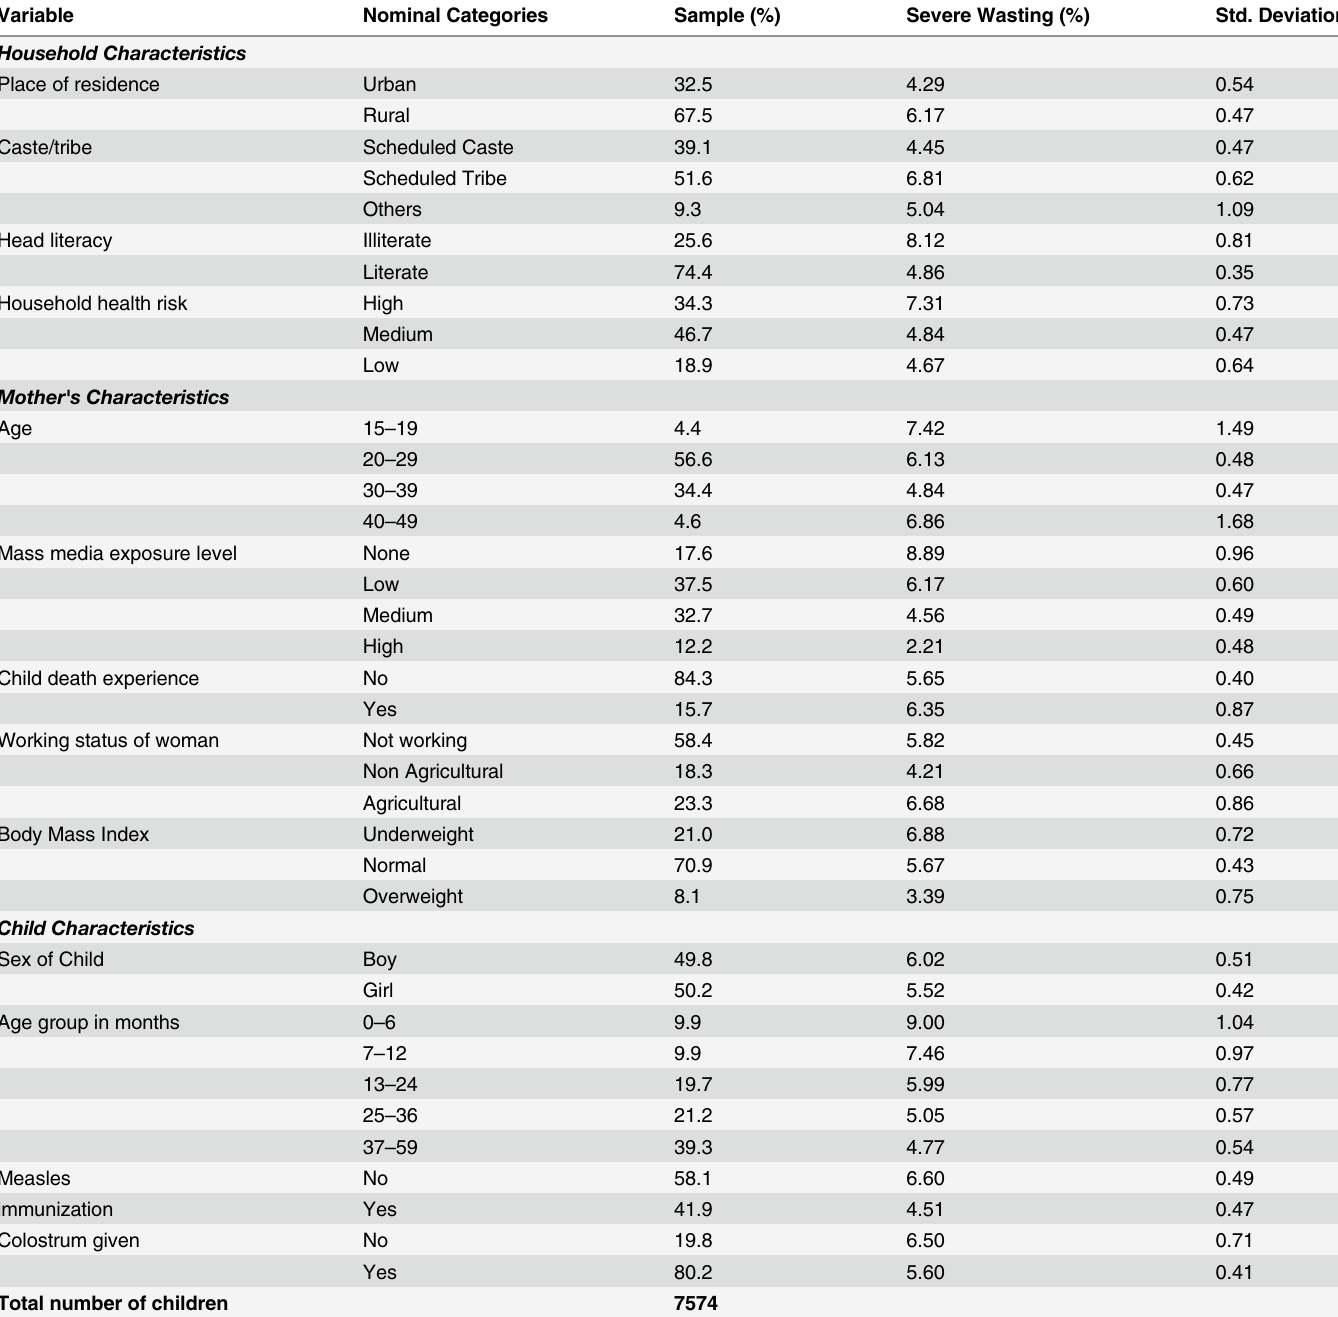
Table 2. Prevalence of severe wasting among children 0 – 59 months in northeast India by selected household background, parental and child characteristics, 2005 – 06.